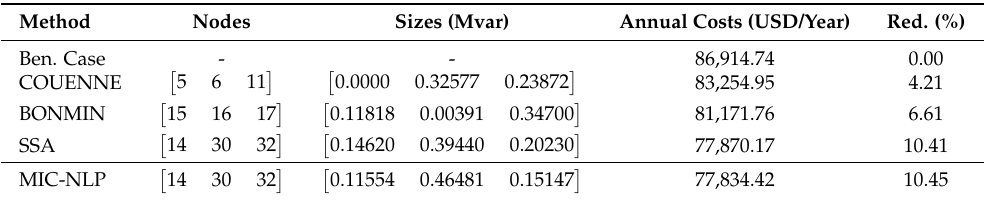
Table 7. Optimal solutions reached by the comparison and proposed optimization methods with fixed reactive power injection in a meshed grid